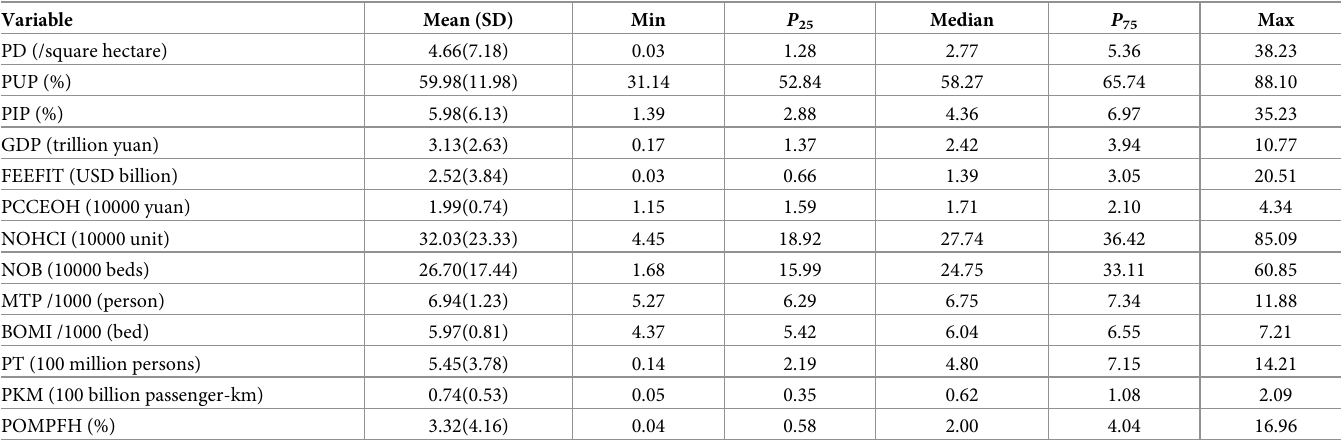
Table 1. Descriptive statistics of socioeconomic variables of the 30 provinces in mainland China (outsides of Hubei). Variable Mean